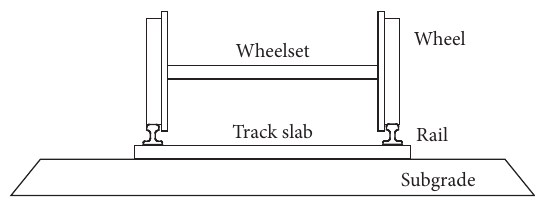
Figure 1: Wheel-track-subgrade calculation model.